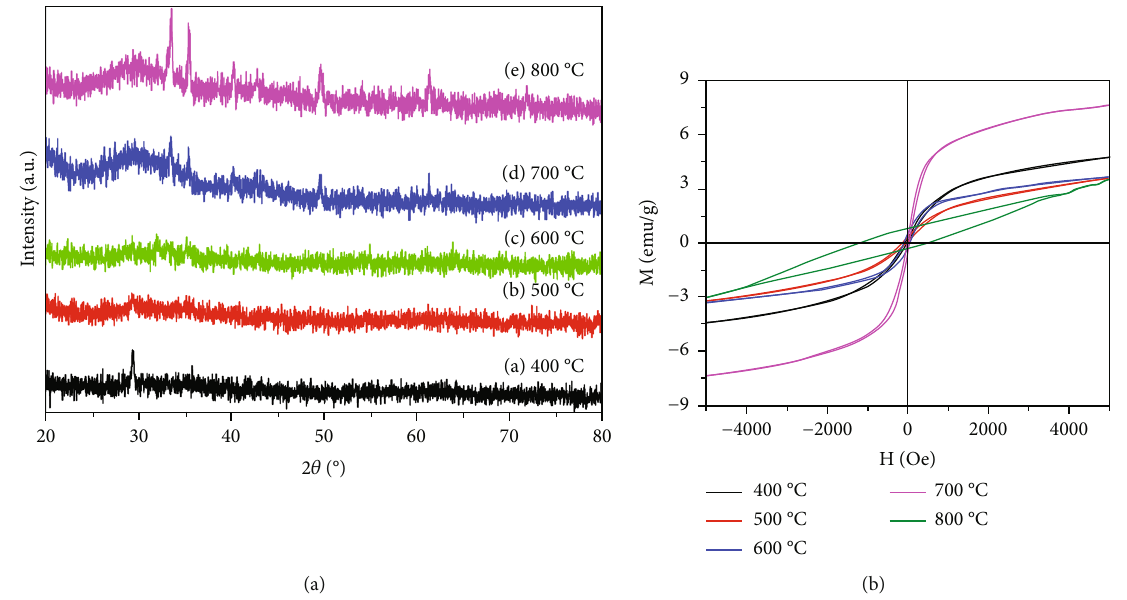
Figure 2: XRD patterns (a) and hysteresis loops (b) of CaFe